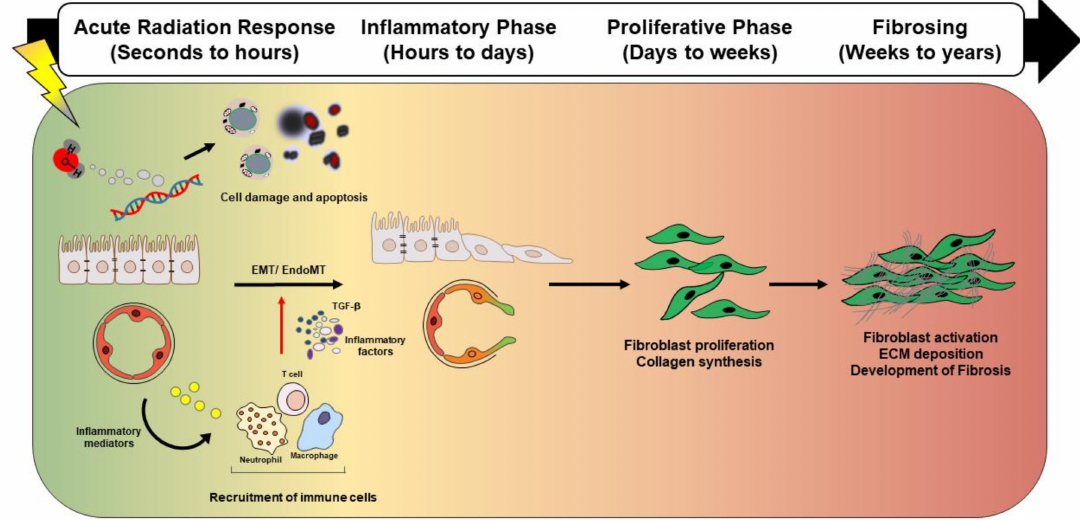
Figure 1. Schematic representation showing distinct and overlapping stages of radiation-induced lung injury. Radiation-induced lung injury consists of overlapping and highly coordinated stages of acute radiation response, inflammation, proliferation, and fibrosis. After lung injury, ionizing radiation induces reactive oxygen species (ROS) induction, DNA damage, and vascular damage. Damaged epithelial cells and / or endothelial cells release inflammatory mediators that recruit immune cells. The recruited immune cells secrete profibrotic cytokines such as IL-1 β , TNF, IL-13, and TGF- β . Secreted cytokines amplify the inflammatory response and trigger fibroblast proliferation and recruitment, which eventually culminates in fibrotic changes. Abbreviation: ROS: Reactive oxygen species, IL-1 β : Interleukin 1 beta, TNF: Tumor necrosis factor, IL-13: Interleukin 13 beta, TGF- β : Transforming growth factor- β , EMT: Epithelial to mesenchymal transition, EndMT: Endothelial to mesenchymal transition, ECM: Extracellular